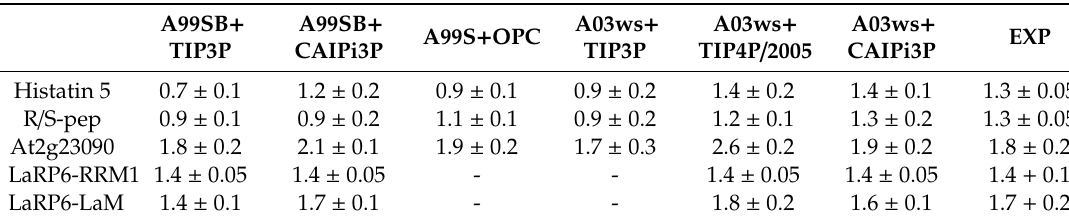
Table 2. Radius of gyration [in nm] for all macromolecules with all used force field and solvent combinations. The error values are the average standard deviation of the replicas. A99SB represents AMBER99SB-ILDN and A03ws represents